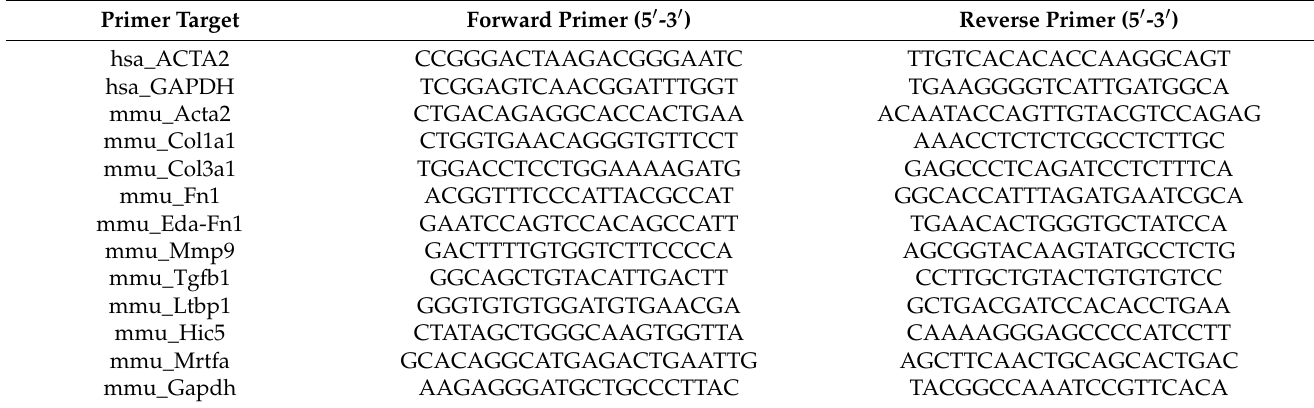
Table 2. Custom primers used for